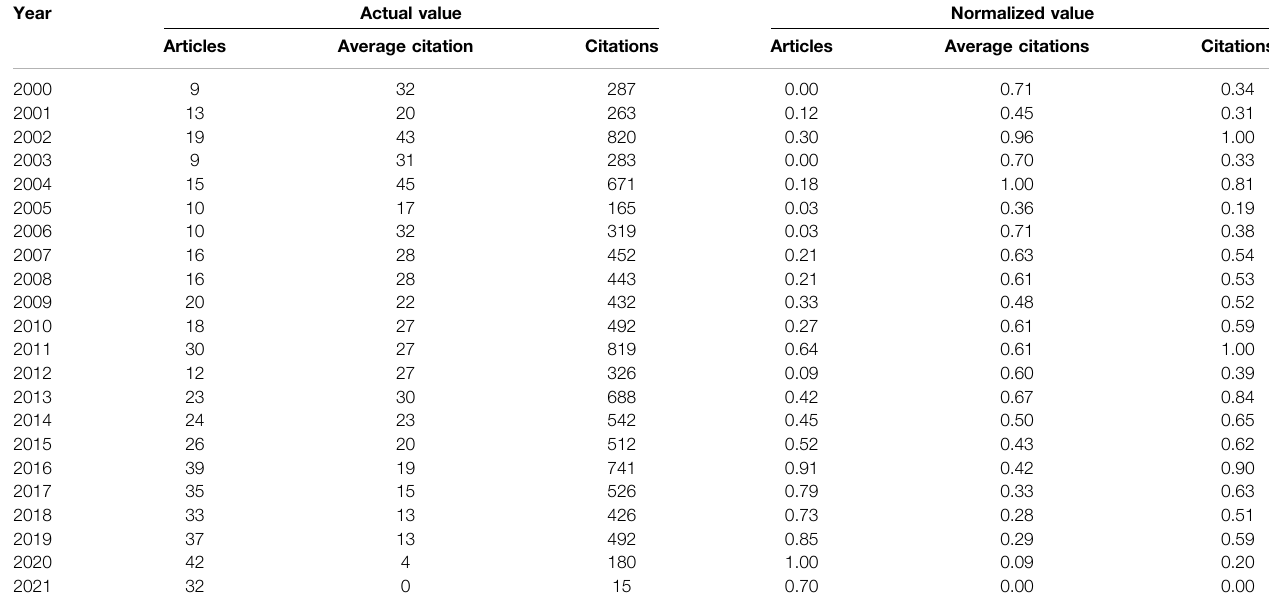
TABLE 2 | Annual scienti fi c productions and citations.